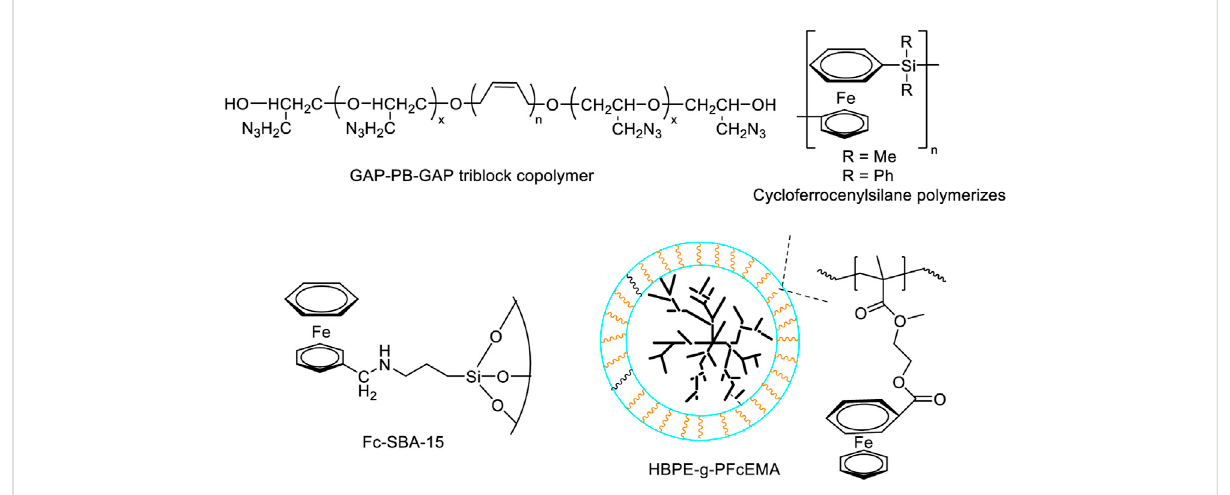
FIGURE 13 Partically loaded burning rate catalyst (Wasudevan and Sundararajan, 1999; Fu et al., 2008; Jiang, 2002; Deng et al.,